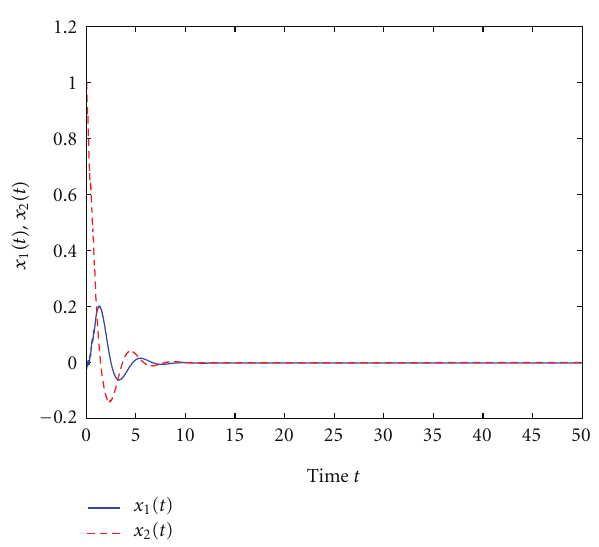
Figure 1: The trajectories of x 1 (cid:2) t (cid:3) and x 2 (cid:2) t (cid:3) of the system (cid:2) 4.1 (cid:3) with time-varying delay τ (cid:2) t (cid:3) (cid:9) 0 . 1 (cid:8) 0 . 75 | sin10 t |